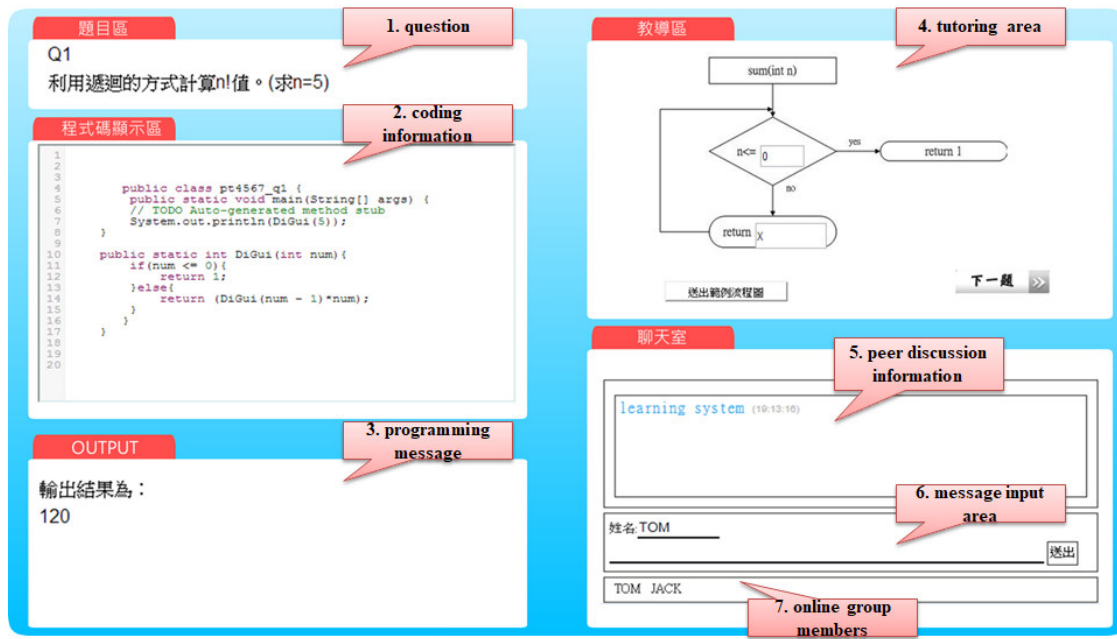
Figure 5. System frame−Experimental group B (tutor).